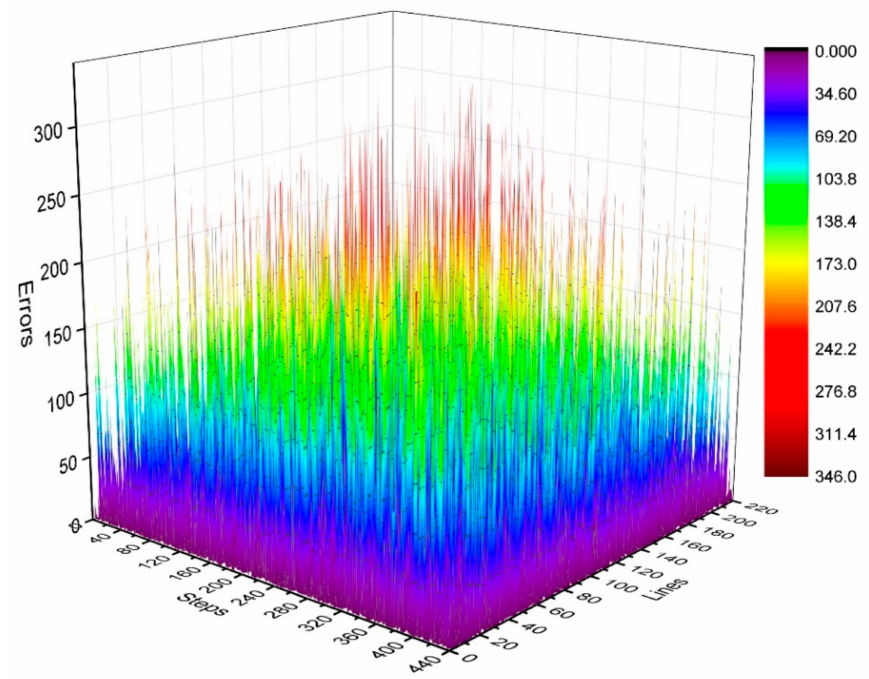
Figure 7. Three-dimensional diagram of phase difference (error) distributions of K τ − 6 and K τ − 12